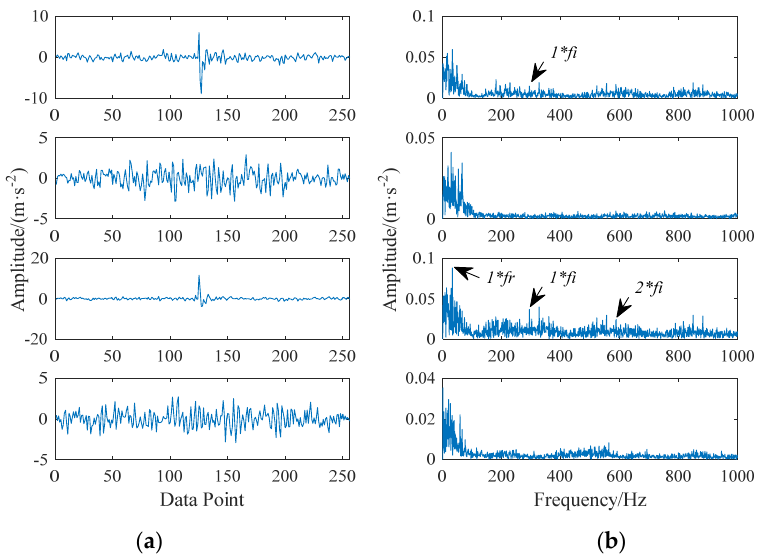
Figure 20. Results obtained with SISC based on a learning dictionary: ( a ) is the base atom obtained by learning; and ( b ) is the envelope spectrum of the reconstructed signal corresponding to the atom.